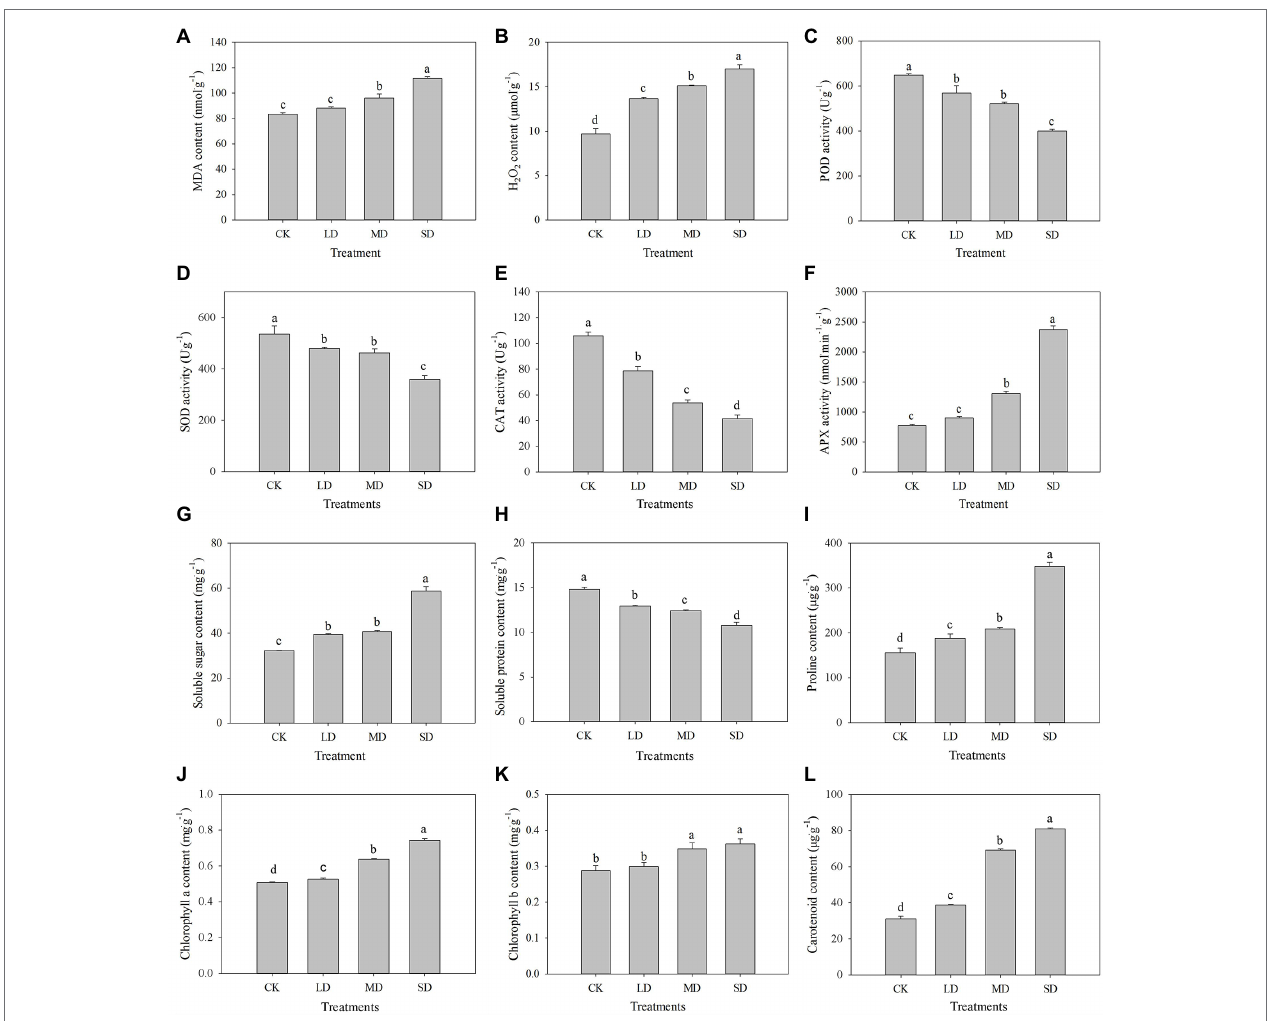
FIGURE 2 | Physio-biochemical characteristics change in S. davidii under different drought treatment conditions. Effects of drought stress on (A) MDA content, (B) H 2 O 2 content, (C) POD activity, (D) SOD activity, (E) CAT activity, (F) APX activity, (G) soluble sugar content, (H) soluble protein, (I) proline content, (J) chlorophyll a content, (K) chlorophyll b content and (L) carotenoid content. The different lowercase letters indicate significant differences ( p < 0.05) for each index among the different drought